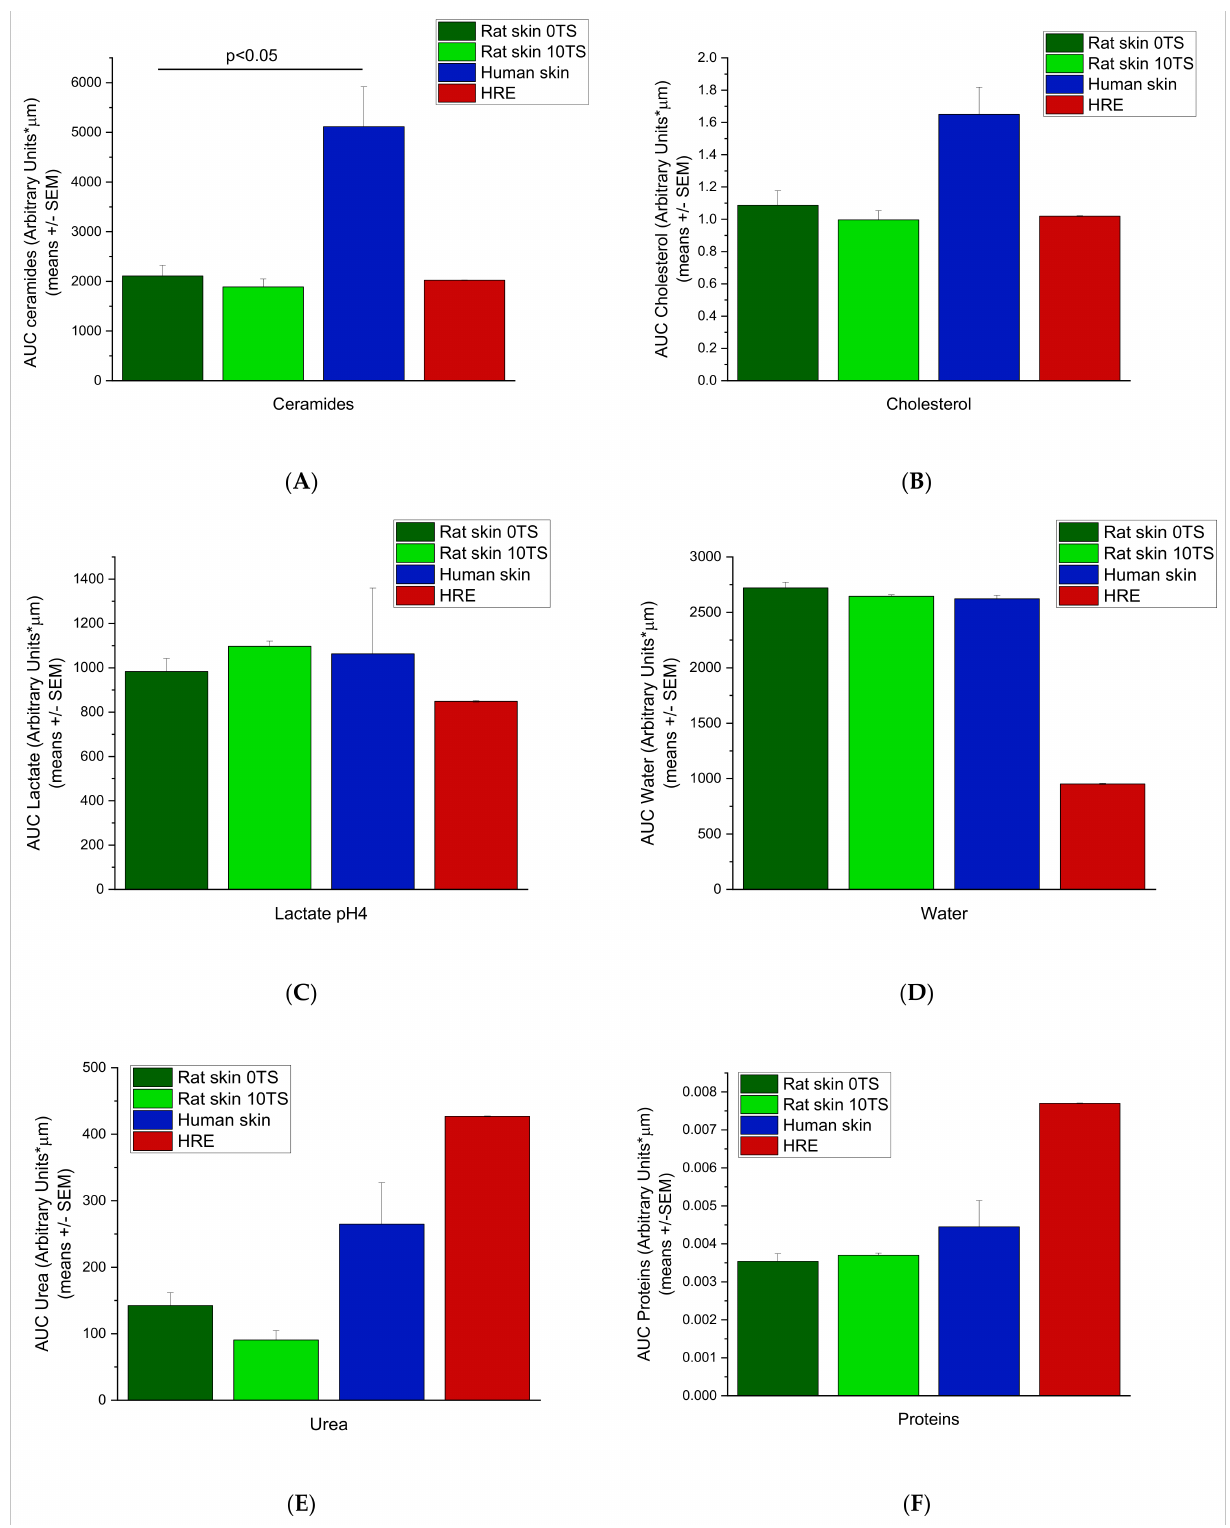
Figure 5. Area under the skin depths—Arbitrary Units curves (AUC) for intact rat skins (0TS), mechani- cally pretreated rat skins (10TS), intact human skins and EpiDerm TM human-reconstructed epidermis (HRE). Measurements were taken on the epidermis at 8–10 different locations for 0–40 µ m depths for water and for 0–28 µ m depths for all the other skin components. (Number of subjects = 3–2, with N = 8–10 locations for each). ( A ) Ceramides, ( B ) Cholesterol, ( C ) Lactate pH = 4, ( D ) Water, ( E ) Urea, ( F )